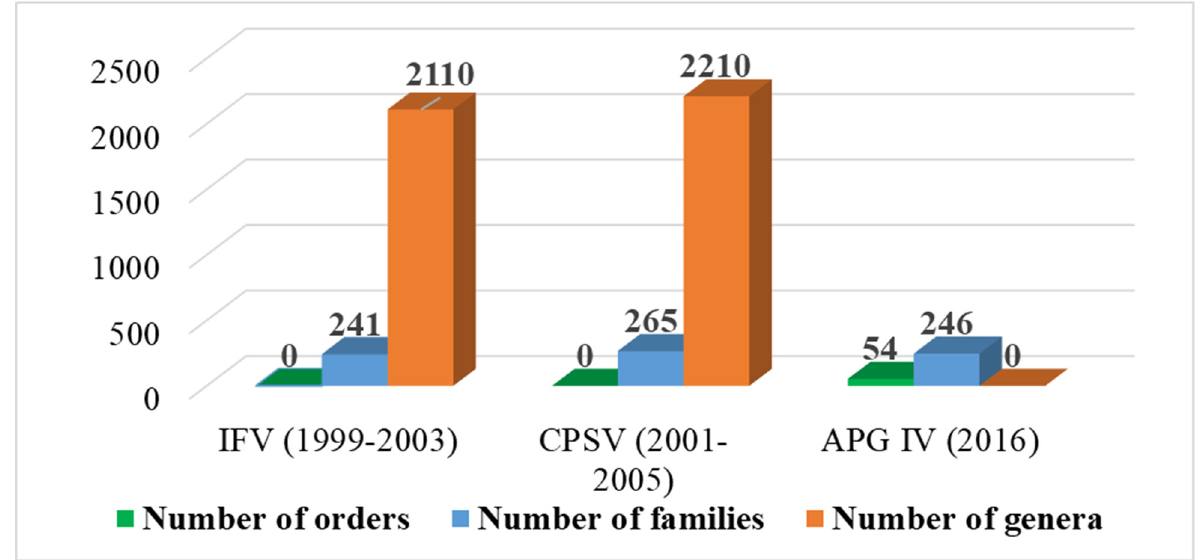
Figure 3. Number of orders, families, and genera of angiosperms in Vietnam according to different treatments.